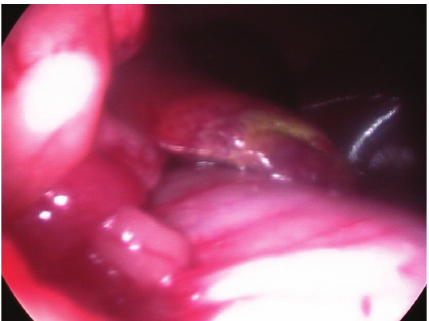
Figure 14: Laparoscopic Procurement of 3mm liver tissue in 7- year-old male mixed-breed dog with hepatic nodular hyperplasia.